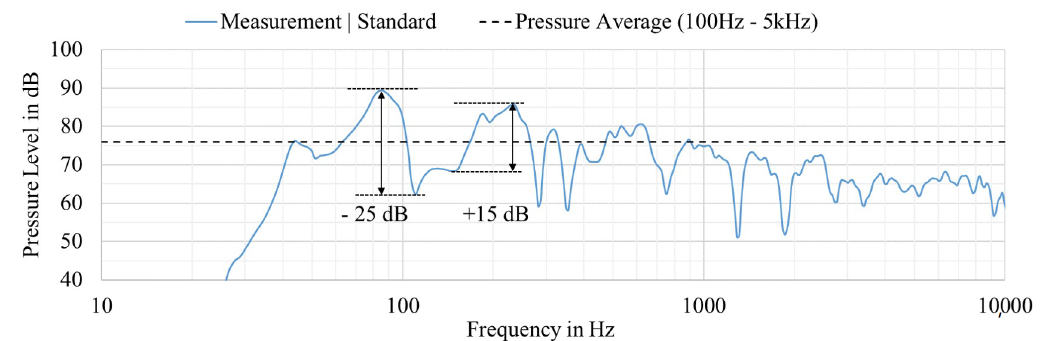
Figure 1. Measured result of a standard flat panel loudspeaker prototype with high deviations in the frequency response at a 1 m distance with 2.83 Vrms